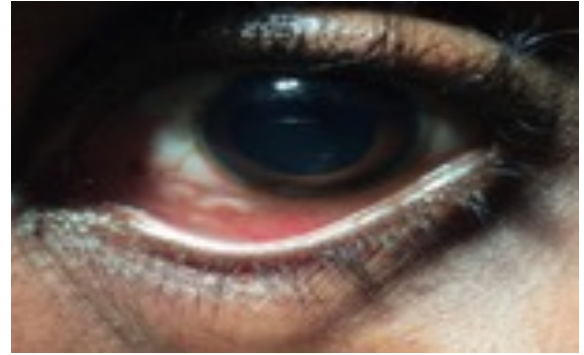
Figure 1: Left eye shows presence of curvilinear nematode in the inferonasal subconjunctival